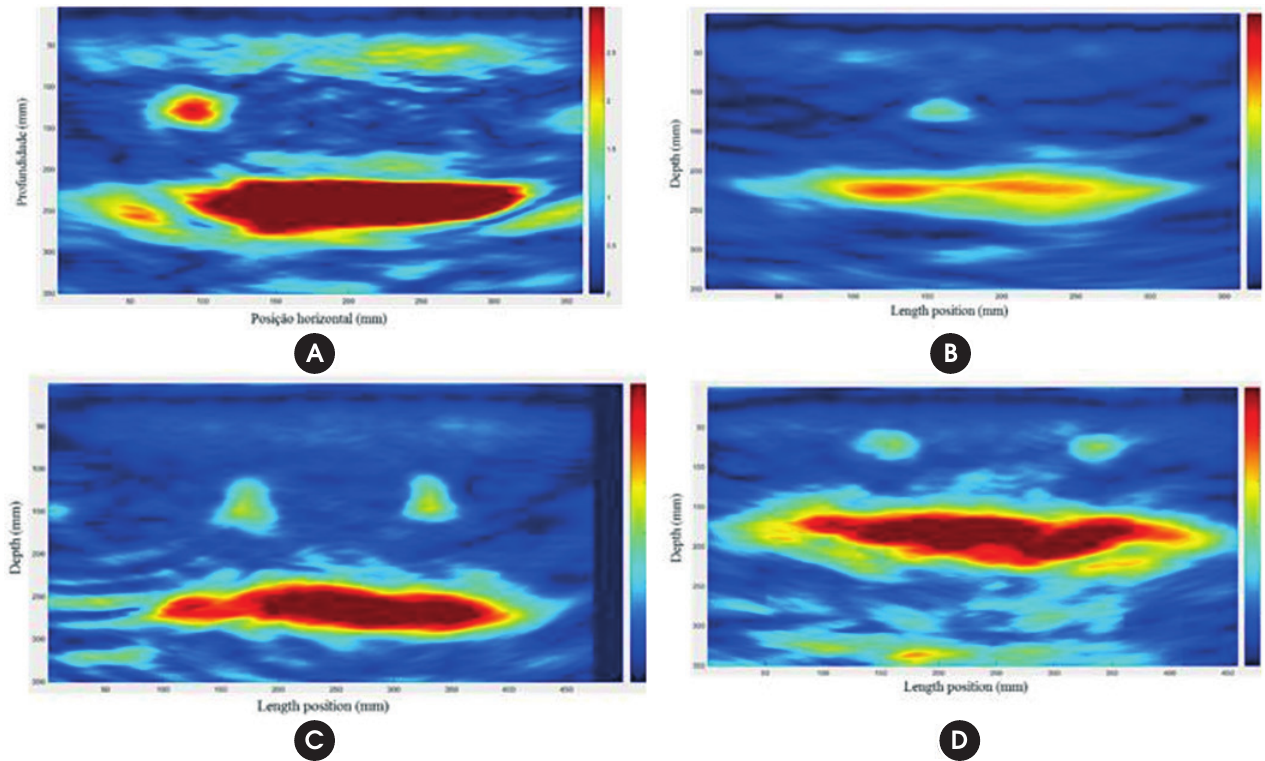
CRCP reinforcement reconstructions